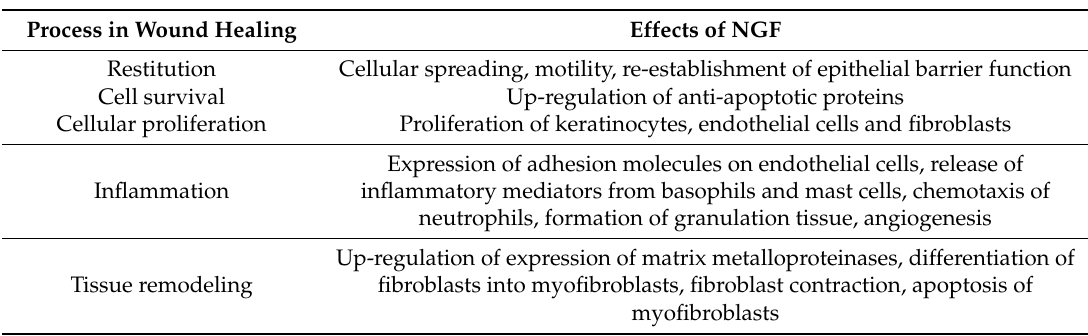
Table 2. The role of Nerve Growth Factor (NGF) in different processes taking place during wound healing in squamous epithelia (skin and oral